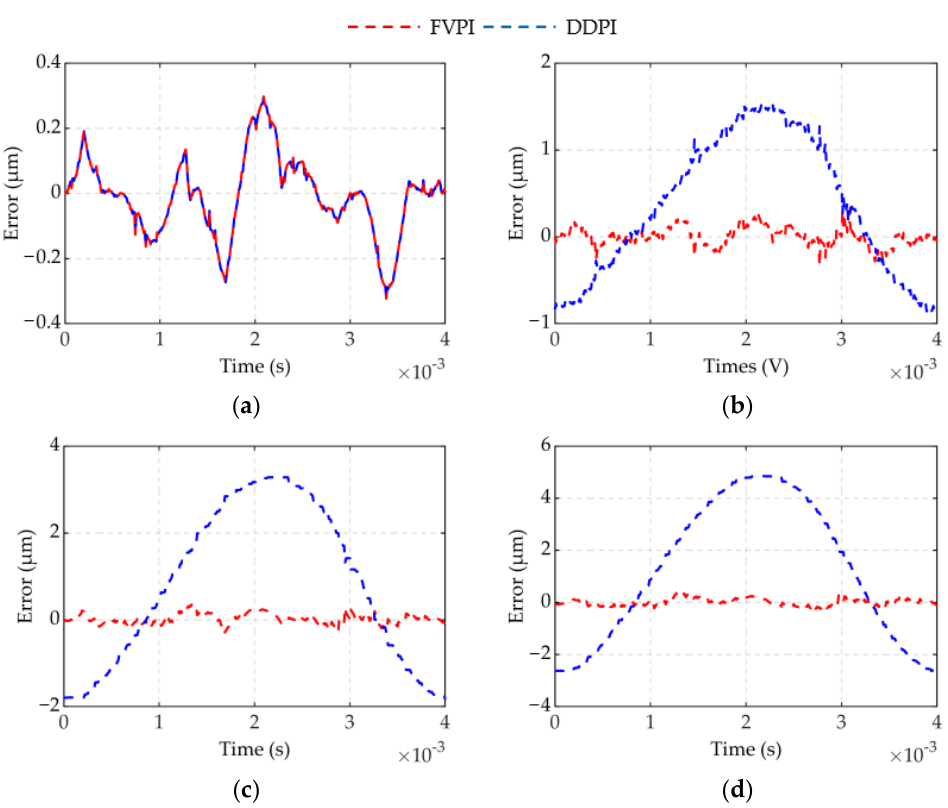
Figure 9. Error of two models at 250Hz under different loads: ( a ) spring 1; ( b ) spring 2; ( c ) spring 3; ( d ) spring 4.